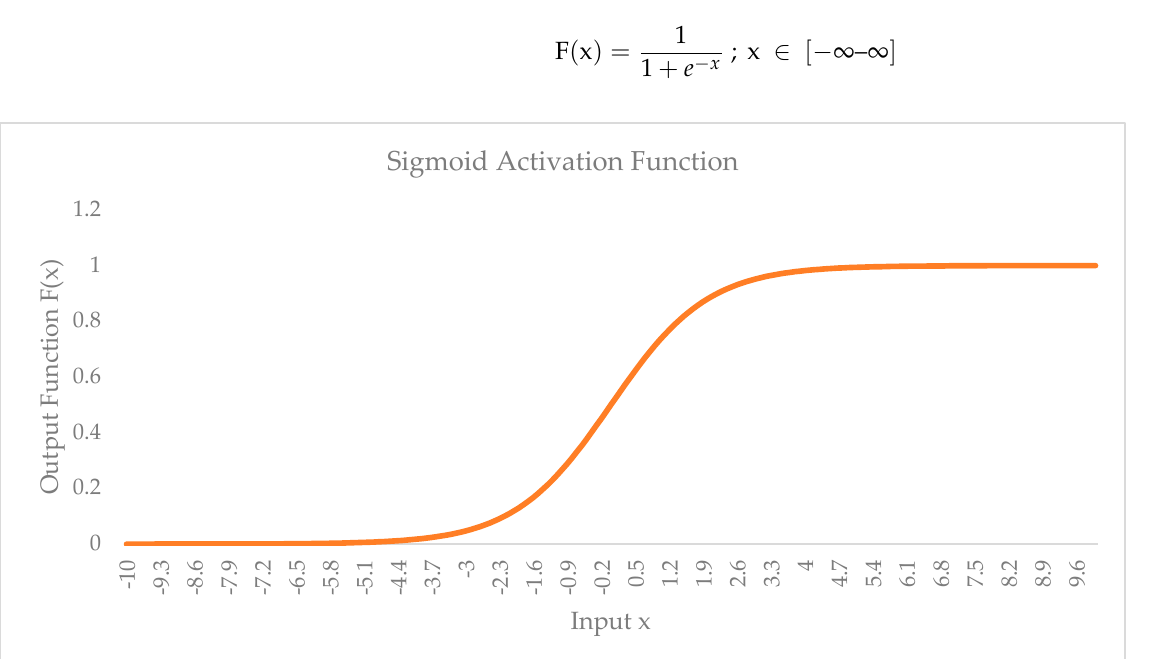
Figure 6. Graphical representation of the sigmoid activation function.